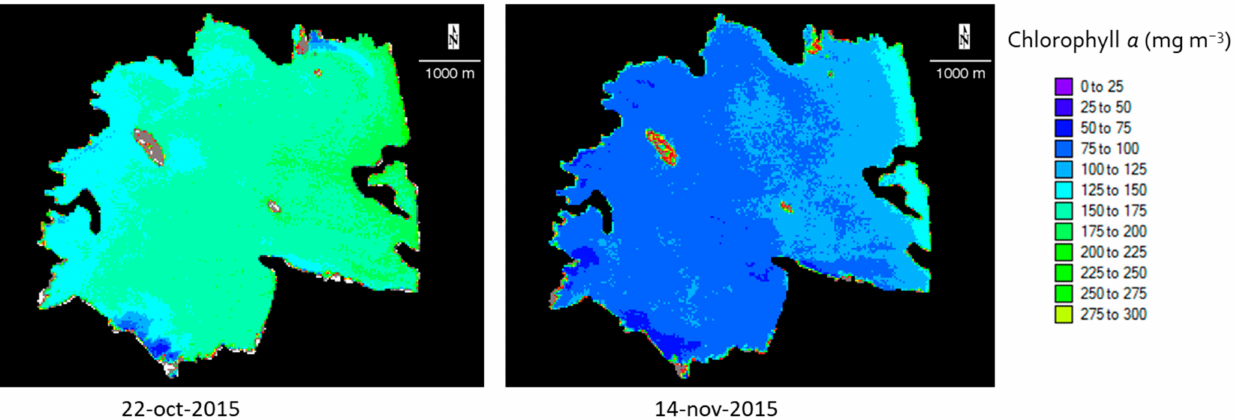
Figure 8. Measurement of chlorophyll a during autumn 2015 using Landsat-8 satellite images in the Albufera of Valencia on a previous date (October) and during the process of renewal by water supply from the west area